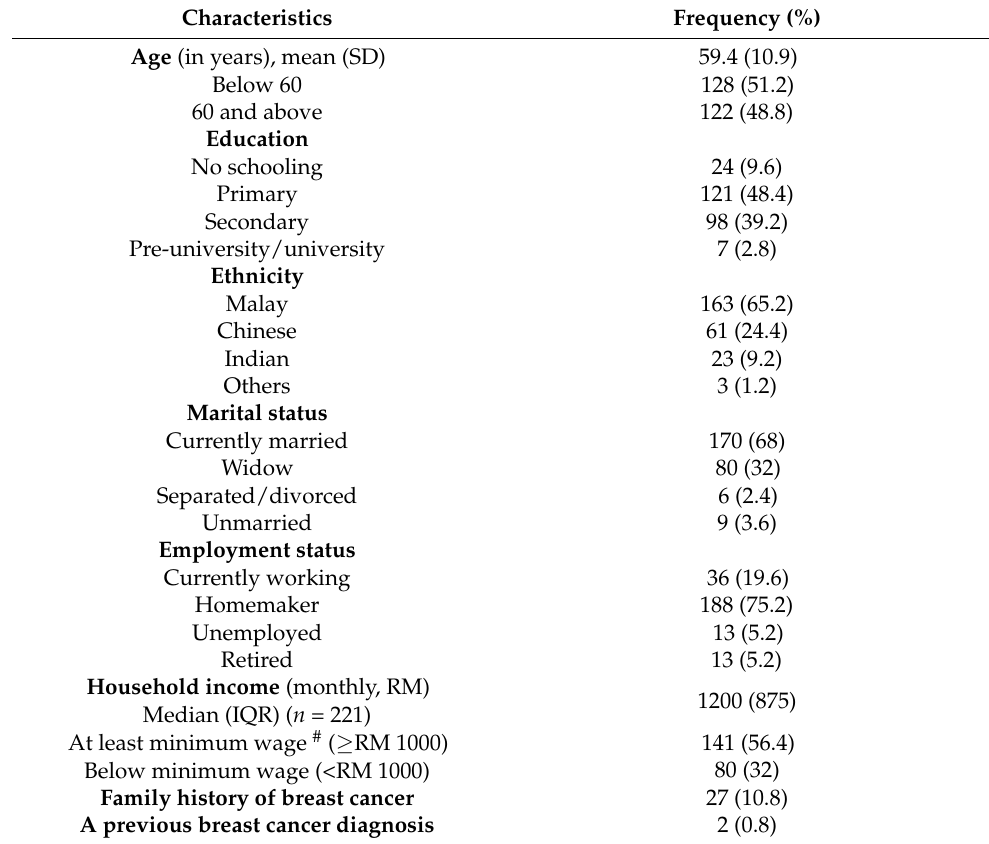
Table 1. Characteristics of study participants ( n = 250).